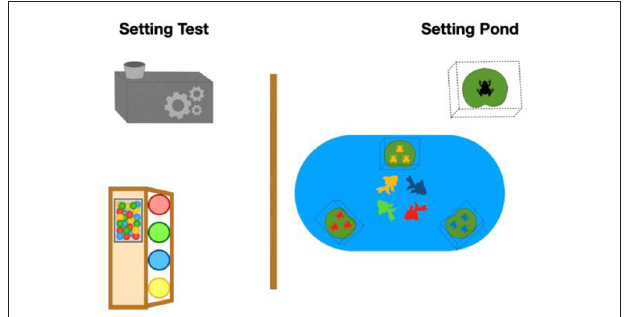
FIGURE 1 | The setting of the field